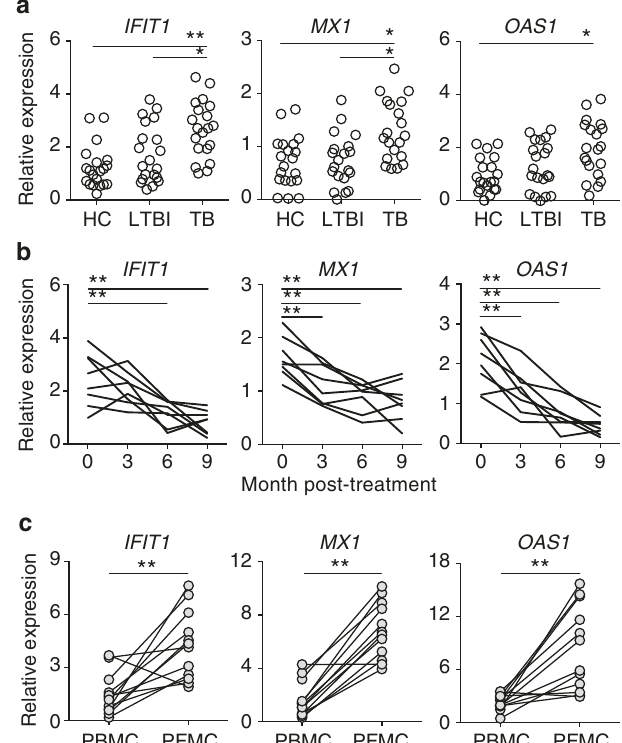
Fig. 1 Expression of a subset of ISGs is associated with active TB disease in Chinese Han populations. ISG mRNA expression in freshly isolated mononuclear cells was determined using qRT-PCR. a ISG expression in PBMCs isolated from HC ( n = 20), LTBI ( n = 20), and active TB patients ( n = 20). b Longitudinal analysis of ISG expression following anti-TB drug treatment ( n = 8). c Comparison of ISG levels in mononuclear cells in paired plural fl uid (PFMC) and blood (PBMC) of plural TB patients ( n = 12). Each symbol/paired symbols/line represents an individual. With the exception of the study described in b , all blood samples were collected before the initiation of anti-TB chemotherapy. Statistical signi fi cance was determined using one-way analysis of variance (ANOVA) for multi-group comparison (in a and b ), and Student ’ s t -test for two-group comparison (in c ). * p < 0.05 and ** p < 0.01. The data shown are fold change in